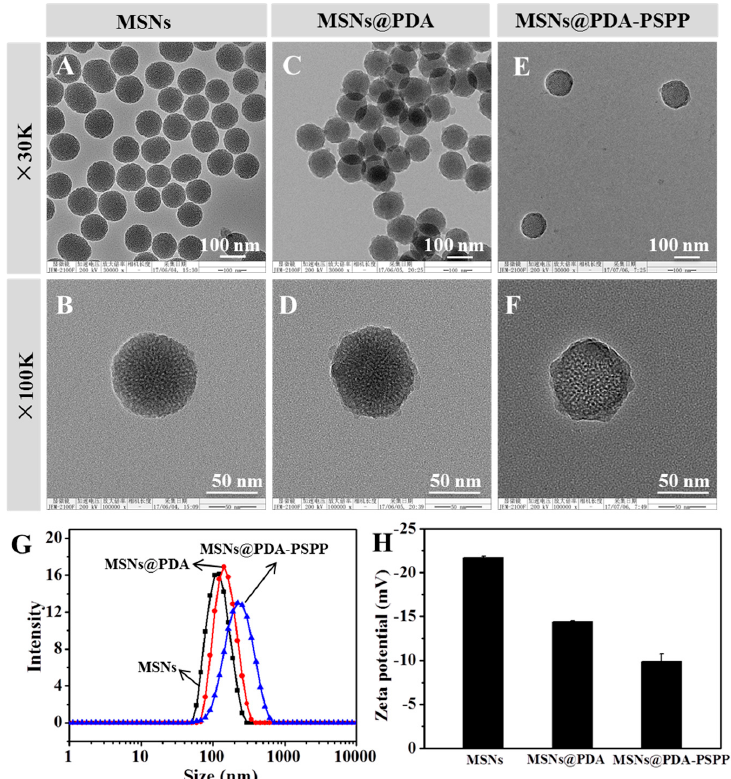
Figure 3. The morphology, size and zeta potential of MSNs, MSNs@PDA and MSNs@PDA-PSPP. The transmission electron microscopy (TEM) images of ( A , B ) MSNs, ( C , D ) MSNs@PDA and ( E , F ) MSNs@PDA-PSPP. The ( G ) average hydrodynamic size and ( H ) zeta potential of the different nanoparticles.